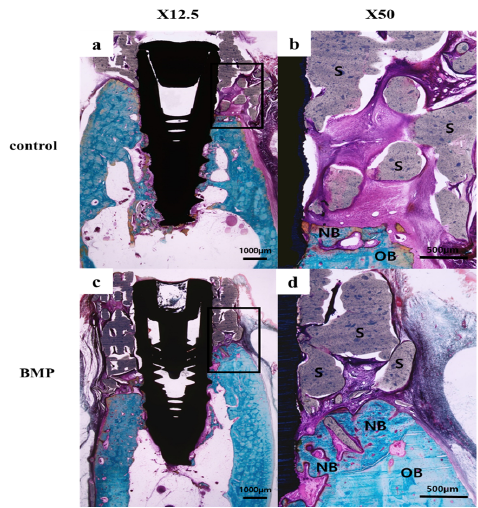
Figure 9. Goldner’s Masson trichrome stain of the histology sections: ( a , b ) Control group; ( c , d ) BMP group. NB : new bone, OB : old bone, S ; scaffold (Original magnification: 12.5× ( a , c ), 50× ( b , d )).